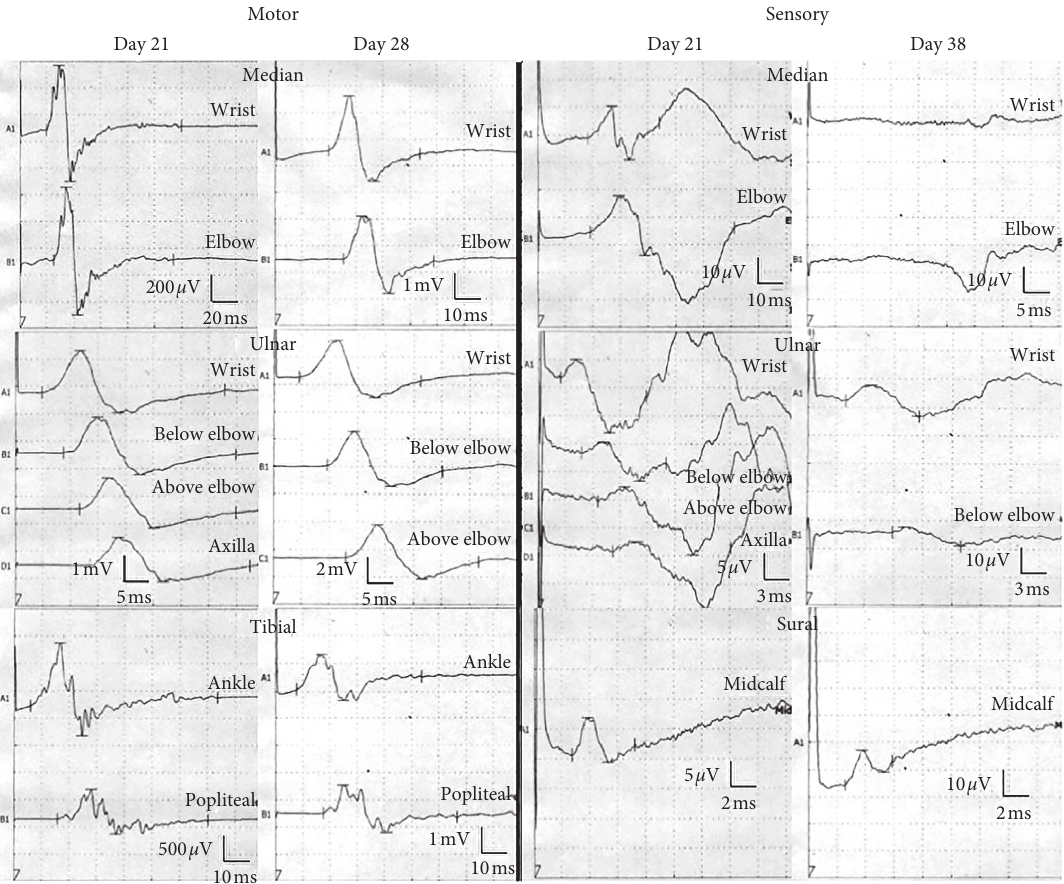
Figure 2: Nerve conduction study results. At 21 days after surgery, the median and tibial motor nerves showed findings of demyelination, such as prolonged terminal latencies, reduction in the compound muscle action potential, a slowed conduction velocity, and temporal dispersion. The ulnar motor nerve showed a decrease in amplitude. The sensory examination showed an abnormal median and normal sural sensory response. The F wave was absent in the bilateral median, ulnar, and tibial motor nerves (data not shown). At 38 days after surgery, the median and ulnar motor nerve compound muscle action potentials had residual prolonged terminal latencies but improved amplitudes. The tibial nerve showed temporal dispersion on both day 21 and day 28 with no improvement. The median and ulnar sensory nerves abnormalities were exacerbated, but the sural nerve remained